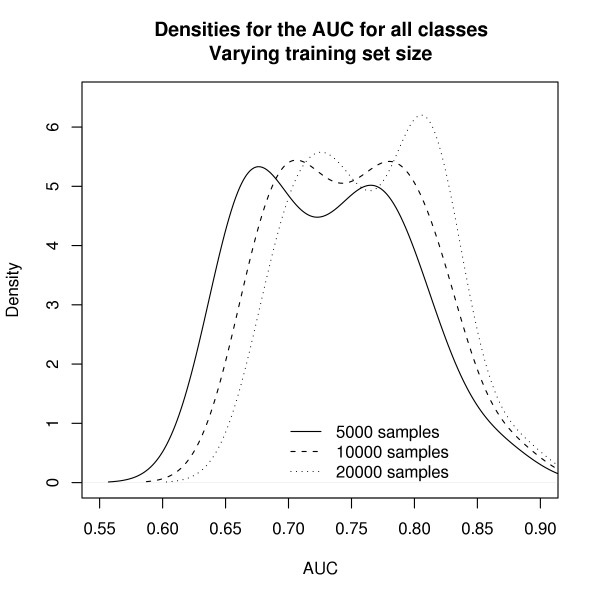
AUC densities for training set sizes 5,000 samples, 10,000 samples, and 20,000 samples (RF classifier). Each of the density curves is generated from the area under the curve performance scores for each of the 27 classes.